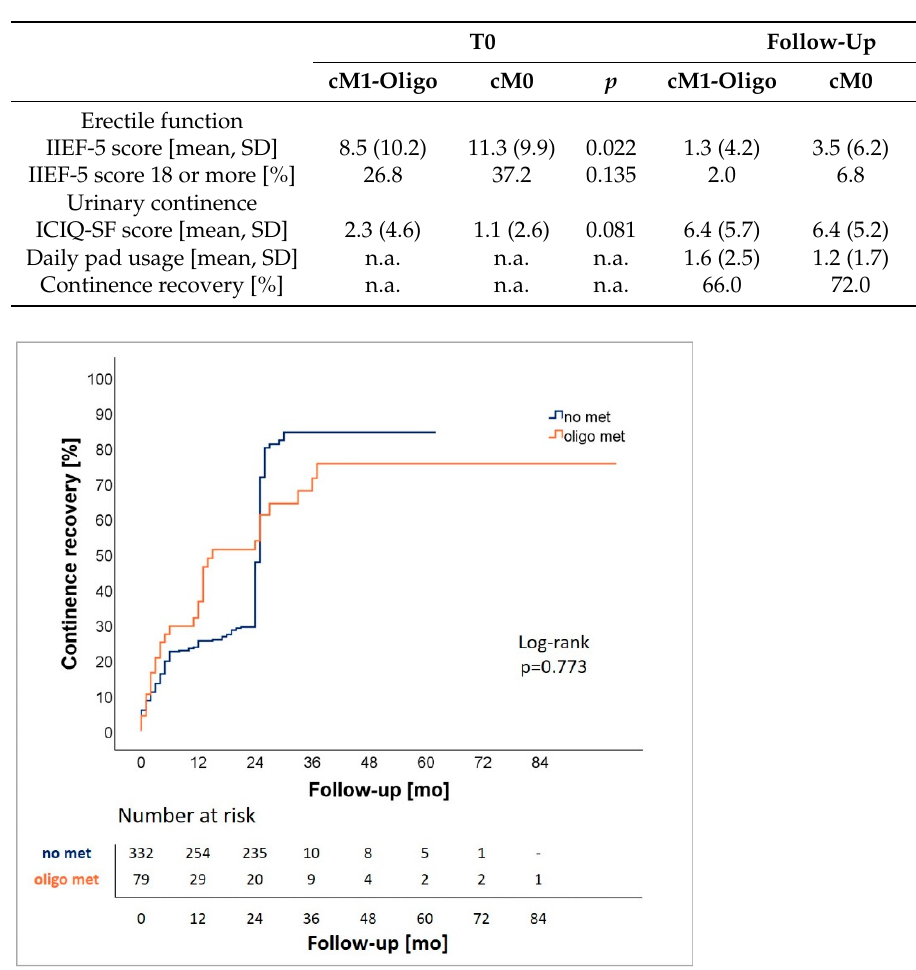
Figure 1. Analysis of continence recovery for patients with (oligo met) and without oligometastatic disease (no met).